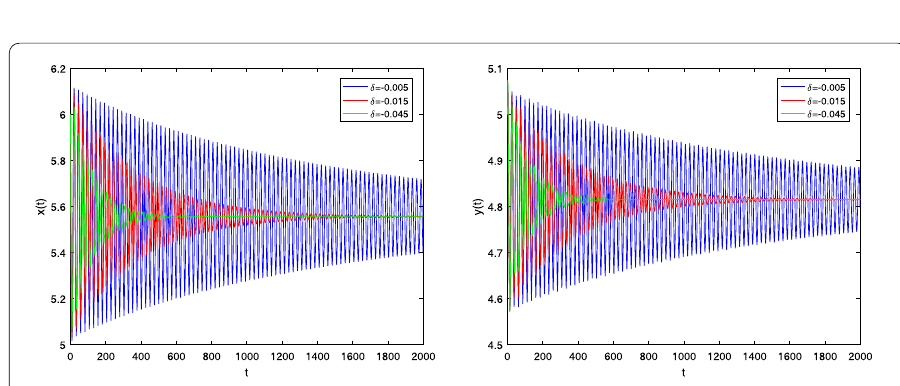
Figure 6 Waveform plots of system (4.24) with initial values (6.46,5.1) in Example 2. This figure illustrates the control effects for the pulse width p = 2 and three different control gain δ = –0.005,–0.015,–0.045